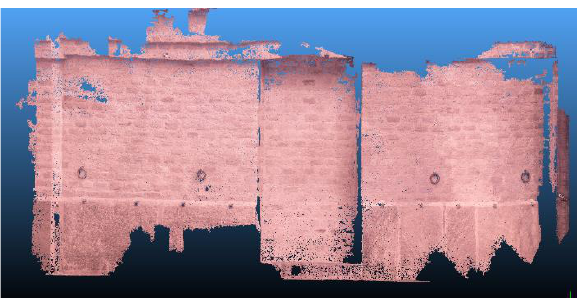
Figure 5: VSfM IRA dense point cloud